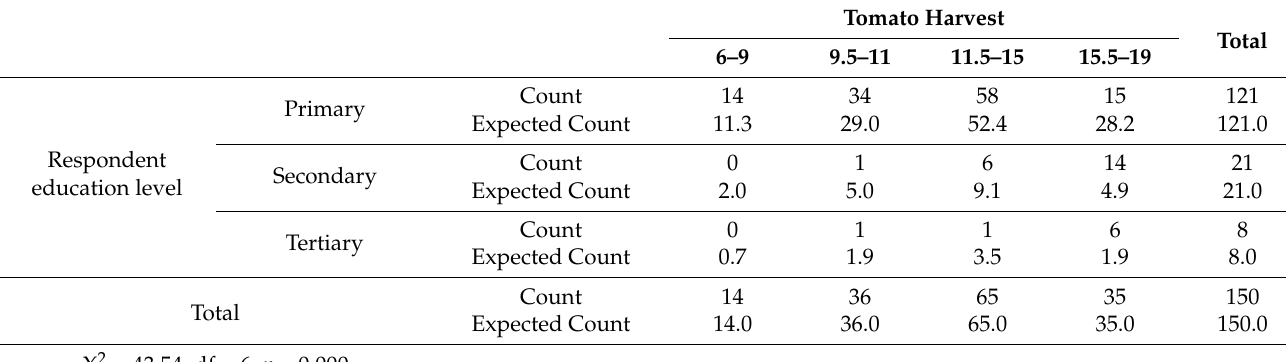
Table 5. Respondents’ education level. Tomato yield (tons/Ha)